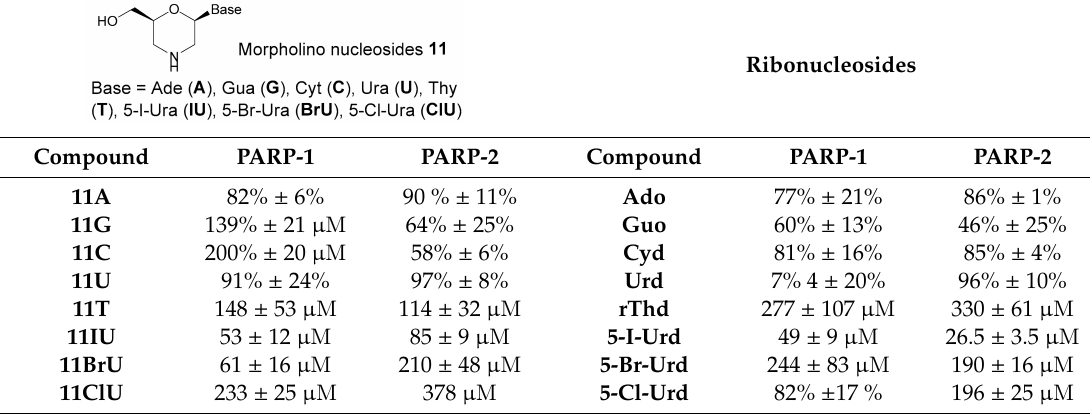
Table 2. Residual PARP-1 and PARP-2 activity (%) or IC 50 , µ М , in the presence of 1 mM morpholino nucleosides and